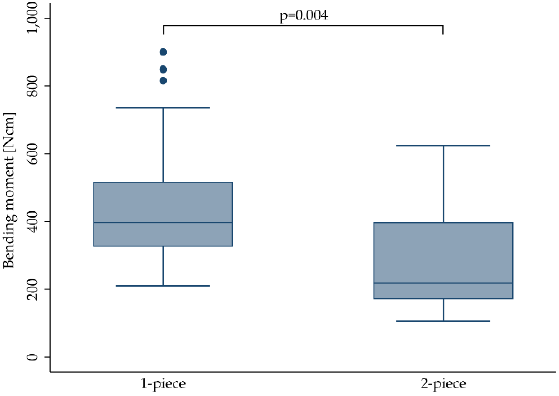
Figure 2. Boxplot showing the bending moment at the time point of fracture for 1- and 2-piece zirconia implants. Whiskers are used to represent all samples lying within 1.5 times the interquartile range (IQR). Dots represent outliers. Detailed data can be found in Tables 3 and 4.